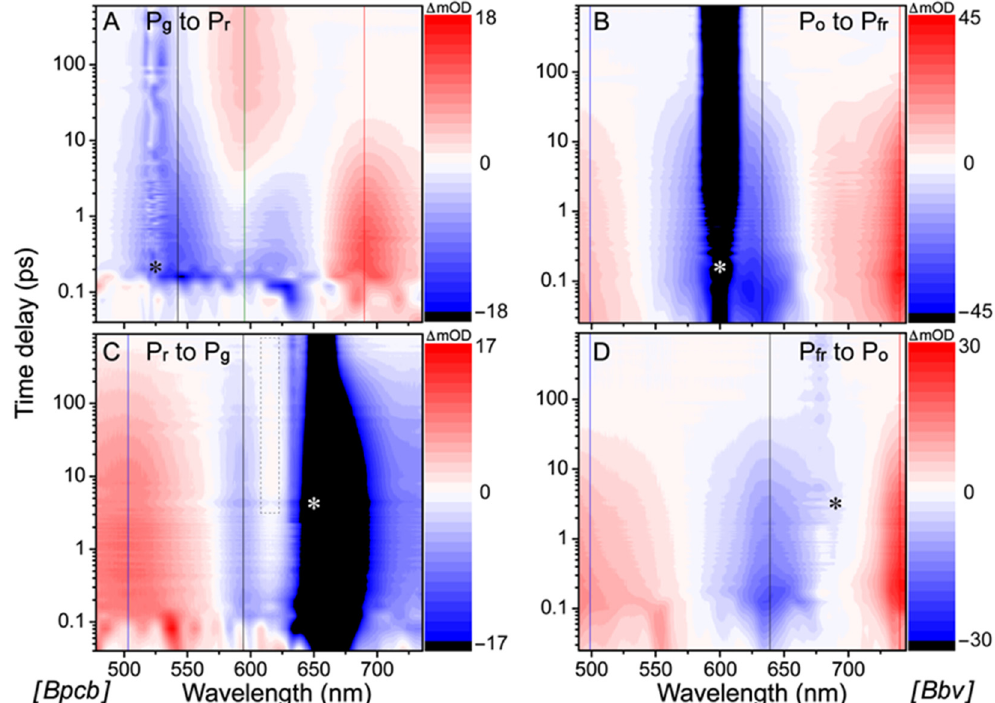
Figure 2. Time-resolved electronic spectra during reversible photoswitching of Bpcb and Bbv in buffer solution. The fs-TA 2D-contour plots of ( A ) Bpcb P g → P r , ( C ) Bpcb P r → P g , ( B ) Bbv P o → P fr , and ( D ) Bbv P fr → P o transitions were collected using a 525 nm actinic pump with 650 nm LEDs, 650 nm actinic pump with 505 nm LEDs, 600 nm actinic pump with 650 nm longpass-filtered tungsten lamp, and 690 nm actinic pump with 600 nm LEDs, respectively, up to 900 ps after electronic excitation. Strong scattering from the pump beam (specific location marked by the asterisk in each panel) was largely removed by subtracting the − 2 ps TA trace from the subsequent traces, although residual scattering can be clearly seen in black (panels B and C ). A weak positive band (light red color) is marked by the dashed rectangle at late times in panel ( C ). Key probe regions for dynamic analysis of the TA marker bands are highlighted by the color-coded vertical lines in each panel (see the associated least-squares fits with retrieved time constants in Supplementary Figure S2).